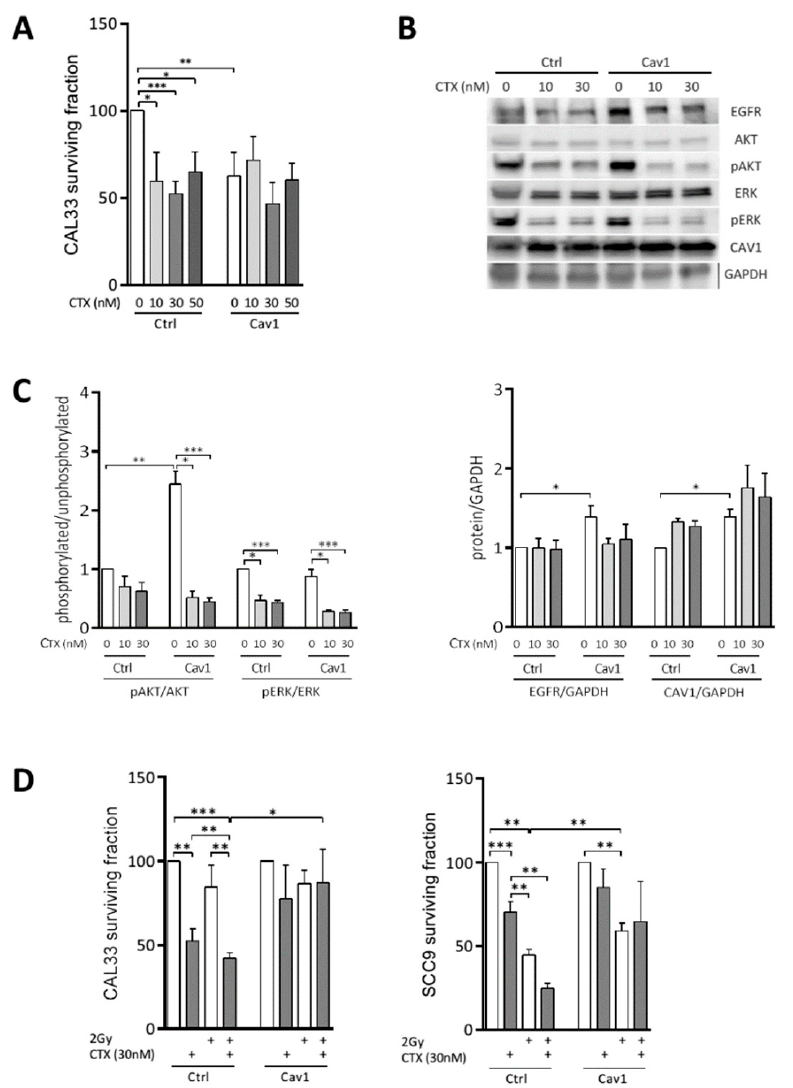
Figure 1. The overexpression of Cav1 enables cells to survive long-term exposure to CTX alone and in combination with radiation. ( A ) Clonogenic survival of CAL33 cells transfected with pEZ-M68 ctrl (CAL33 Ctrl ) or pEZ-M68 cav1 (CAL33 Cav1 ) was determined 10 days after exposure to 10, 30 and 50 nM CTX. Histograms represent the surviving fraction in each condition. The plating efficiencies were 0.21 ± 0.07 and 0.16 ± 0.04 for CAL33 Ctrl and CAL33 Cav1, respectively. Data are represented as the mean ( n = 3–5) ± SEM (* p < 0.05, ** p < 0.01 and *** p < 0.001). ( B ) Expression of EGFR, AKT, phospho-AKT, ERK1/2, phospho-ERK1/2 and GAPDH was determined by Western blot (WB) of lysates from CAL33 Ctrl and CAL33 Cav1 cells exposed 72 h to 0, 10 and 30 nM CTX. Western blots are representative of 3-5 independent experiments. ( C ) Phospho-AKT, phospho-ERK, EGFR and Cav1 levels were analyzed using AKT, ERK or GAPDH as a loading control. Each bar represents the mean ( n = 3–5) ± SEM (* p < 0.05, ** p < 0.01 and *** p < 0.001). ( D ) Clonogenic survival of SCC9 Ctrl , SCC9 Cav1, CAL33 Ctrl and CAL33 Cav1 was determined 10 days after exposure to 2 Gy irradiation, 30 nM CTX and a combination of both. Histograms represent the surviving fraction in each condition. Data are represented as the mean ( n = 3–5) ± SEM (* p < 0.05, ** p < 0.01 and *** p < 0.001).